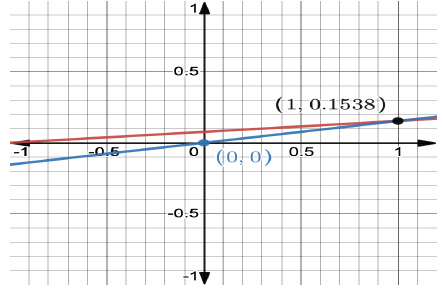
( x ) = 2 x (blue). 3 13